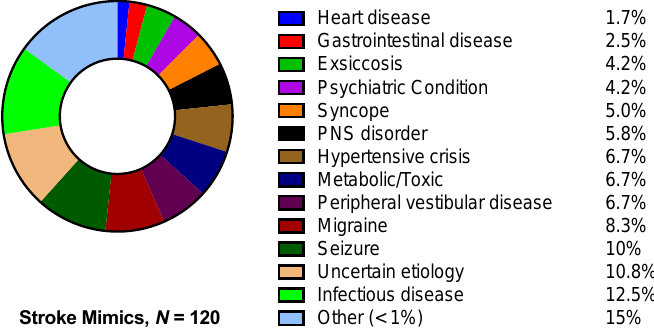
Figure A1. Types of stroke mimics. PNS, peripheral nervous system.